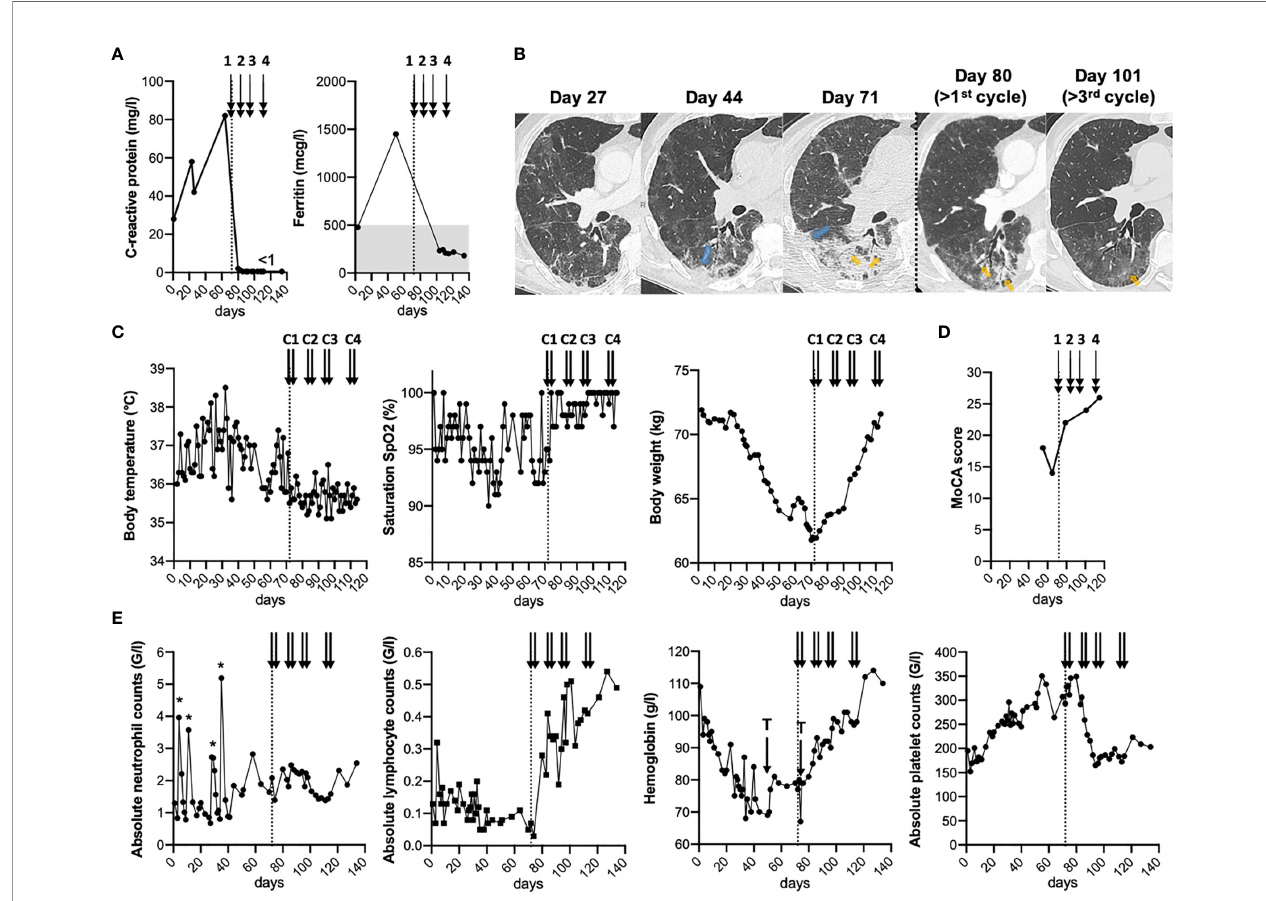
FIGURE 1 | Clinical, biological and radiological follow-up before and after plasma transfusions. (A – E) , Timeline of chronic SARS-COV-2 infection in a severely immunosuppressed patient showing in fl ammatory markers (A) , chest CT scan (B) , clinical parameters (C) , MoCA (Montreal Cognitive Assessment) scores (D) , and complete blood counts (E) . (B) , Axial slices focused at the level of the apical segment of the right lower lobe. Progressive worsening from multiple ill-de fi ned areas of ground glass opacities progressing to patchy alveolar consolidation of increasing size. Note the subpleural (blue arrows) and peribronchial (orange arrows) distribution of the lesions with progressive improvement on post-therapeutic follow-up, alveolar consolidation being replaced by ground glass opacity. (A – E) , Arrows indicate the 4 cycles of plasma transfusion (two units given on two consecutive days of each cycle). The “ * ” show the three injections of granulocyte-colony stimulating factor ( fi lgrastim), while “ T ” indicates the two red blood cell transfusions. Of note, fi lgrastim injections (< day 40) and red blood cell transfusions did not result in symptom